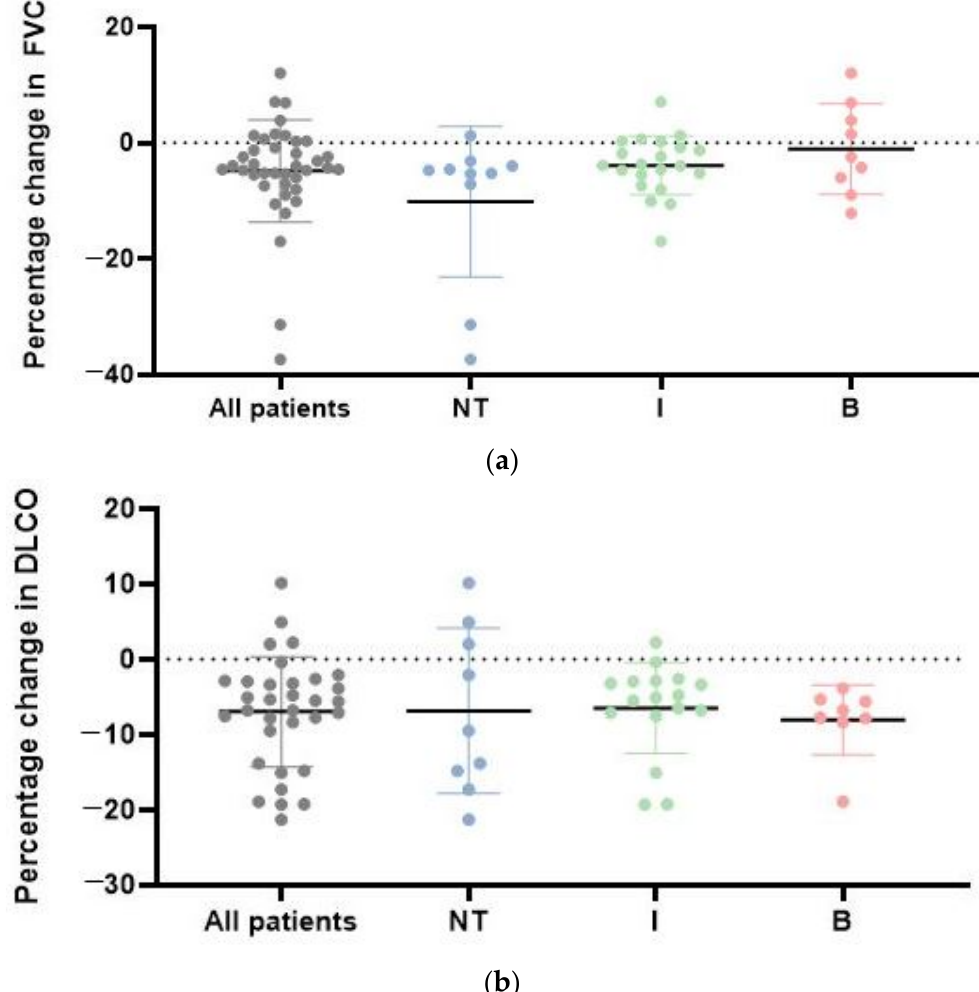
Figure 2. ( a ) Annual FVC changes in all SSc-ILD patients and in the specific treatment groups. Description of what is contained in the first panel; ( b ) annual DLCO changes in each specific treatment group; DLCO, diffusing capacity for carbon monoxide; FVC, forced vital capacity; I = ISU therapy; NT = No treatment; I = ISU therapy, B = Biological therapy.